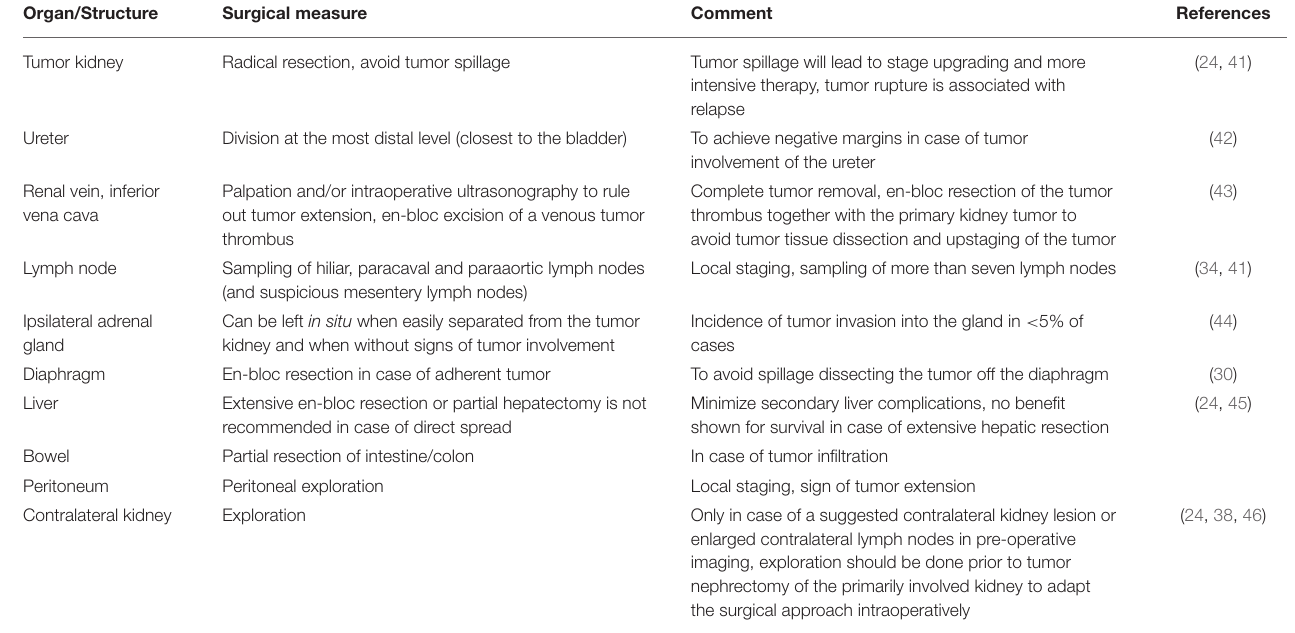
TABLE 3 | General surgical principles in unilateral WT to achieve local